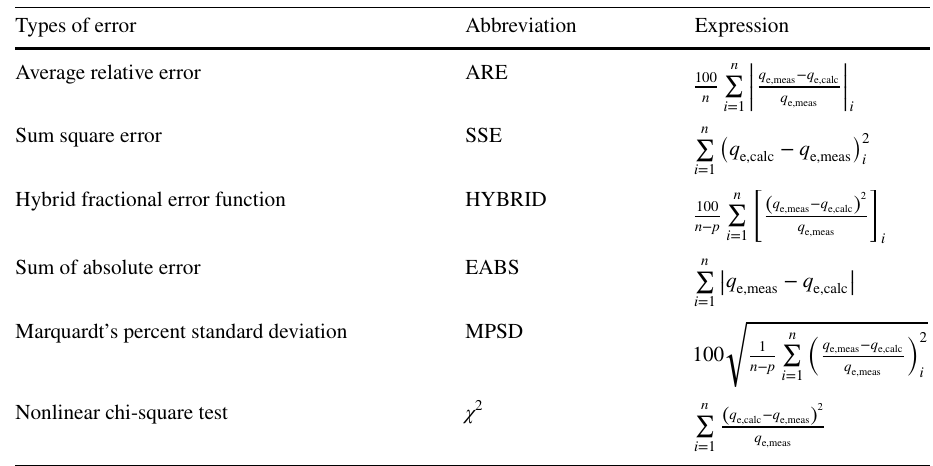
q q e, calc and e, meas are calculated and measured adsorption capacity, respectively, mental data points and p is the number